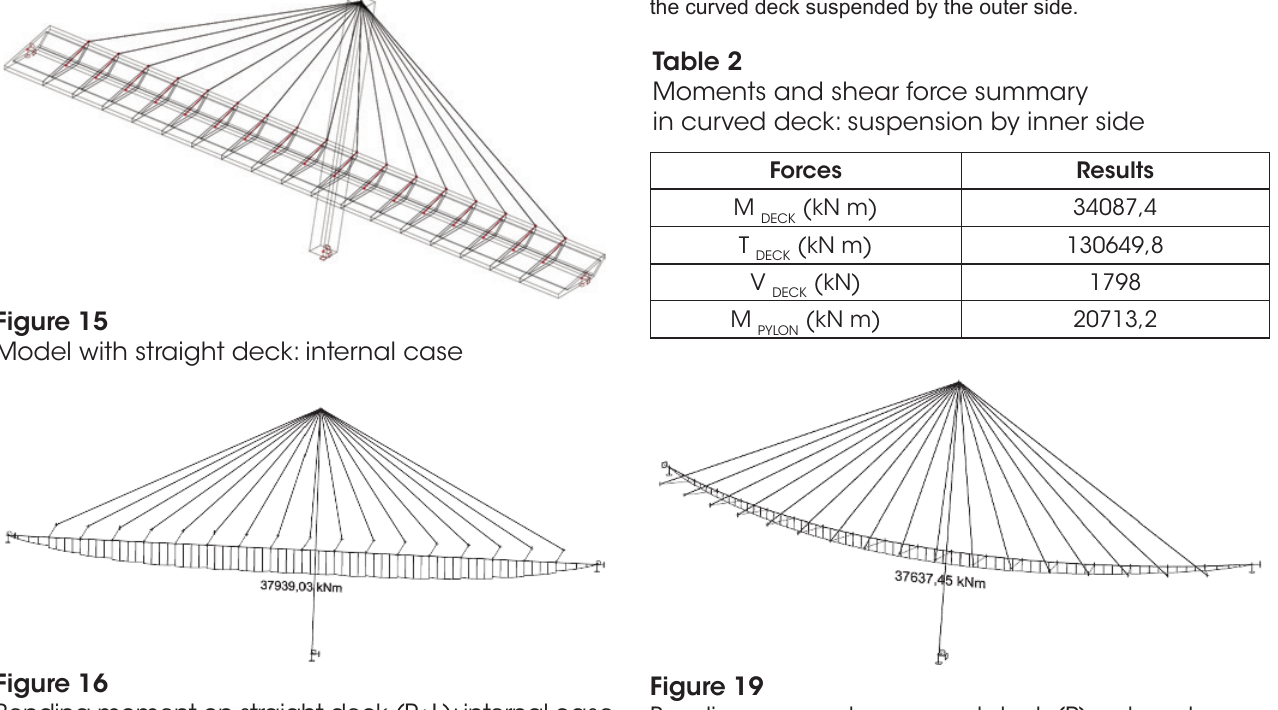
Bending moment on curved deck (P): external case